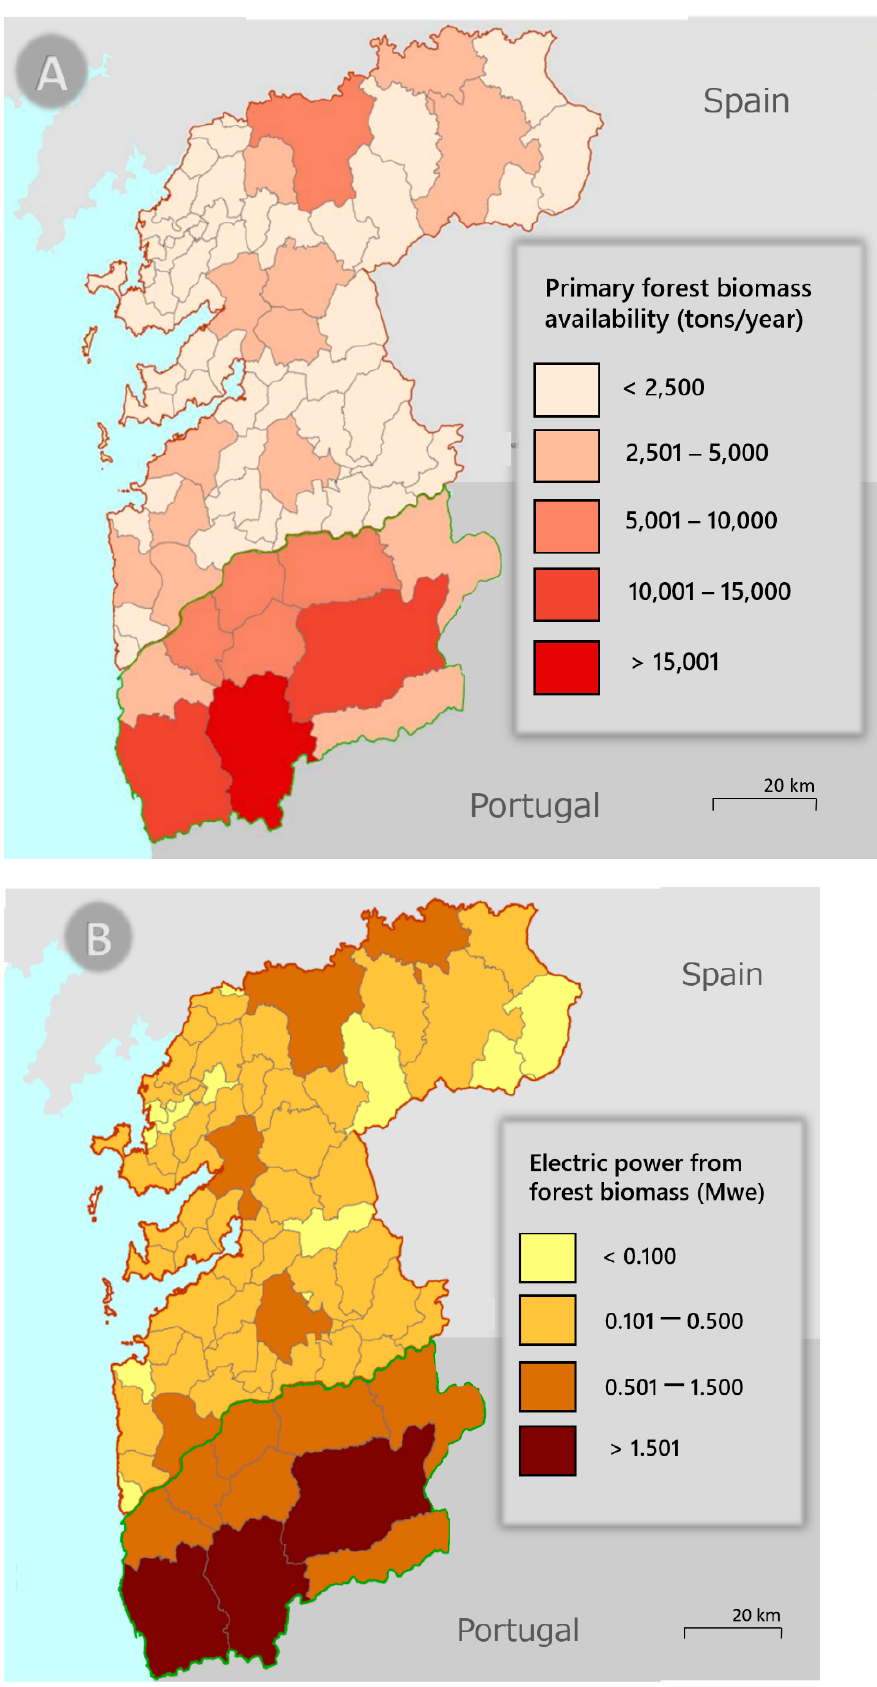
Figure 2. ( A ) The availability of primary forest biomass; ( B ) electric power from forest biomass.